Question: In a single sentence, describe what this figure presents.
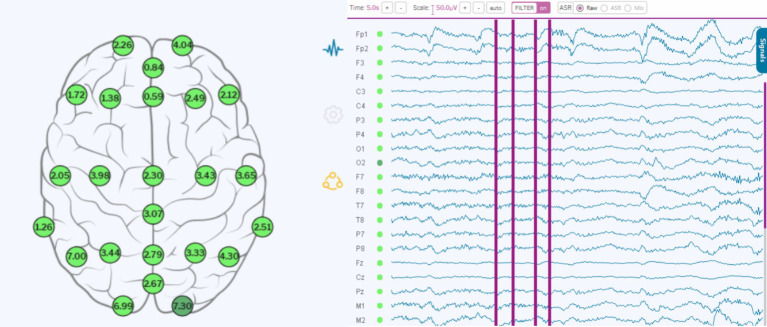
Answer: EEG recording session, electrode placement and spatial signal distribution. (Left) Two-dimensional topographic cortical mapping showing the international 10–20 system electrode configuration, with specific localized numerical activation/metric values overlaying each green channel node. (Right) Concurrent multi-channel time-series EEG waveforms mapped from frontal to mastoid channels Fp1 through M2.